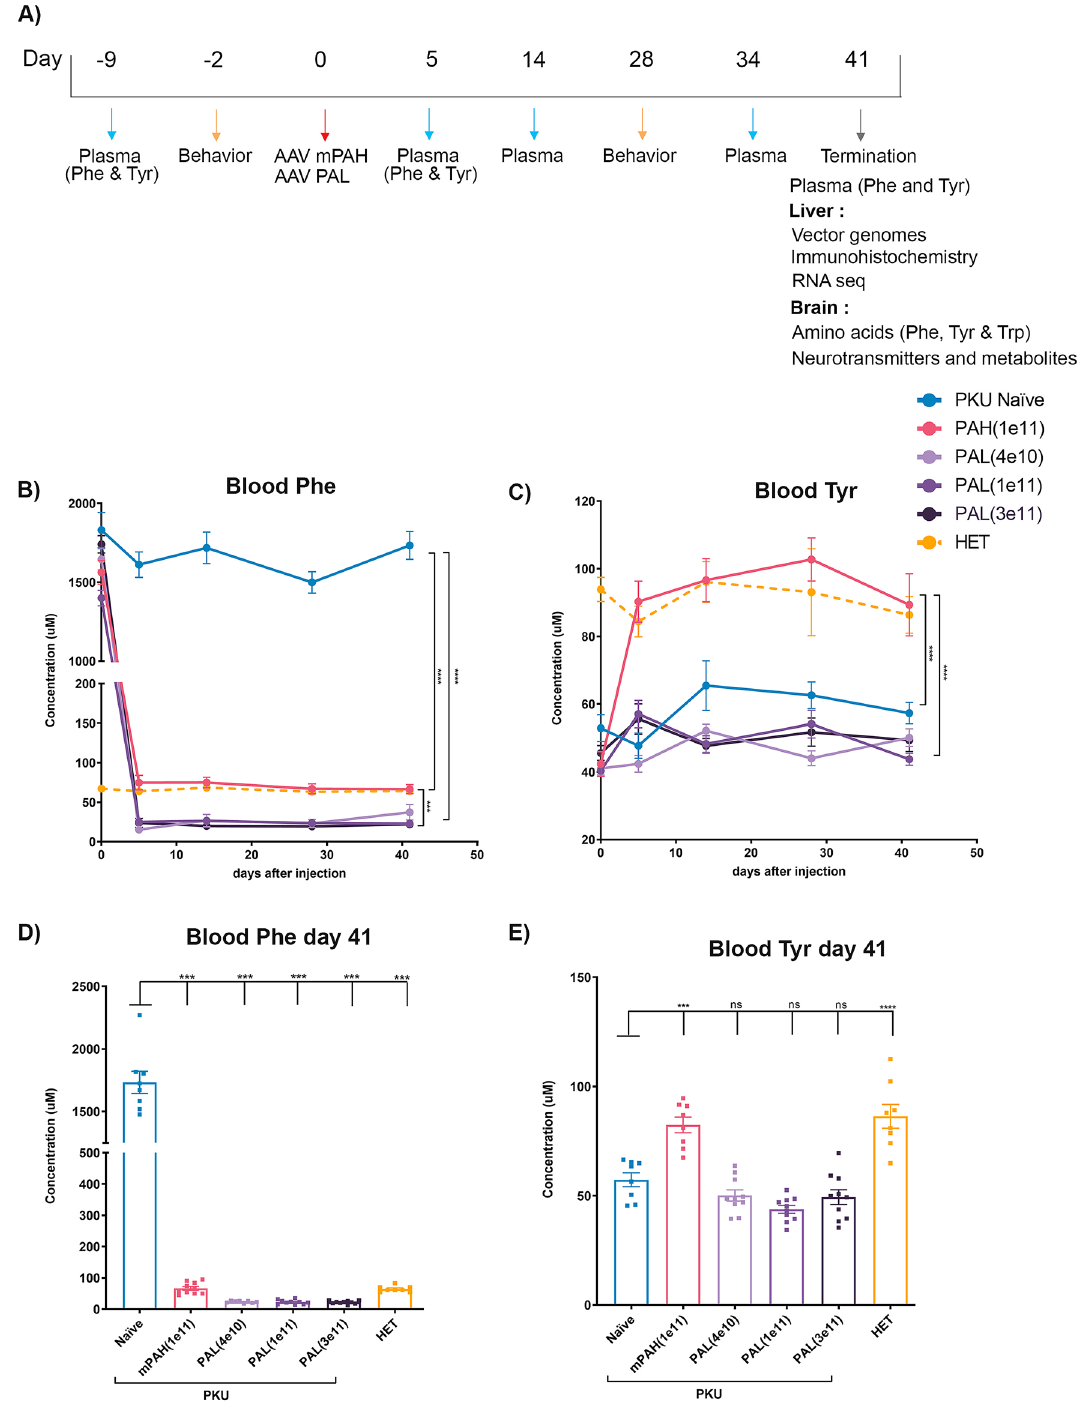
Figure 1. Effect of PAH and PAL gene transfer on blood Phe and Tyr levels after gene delivery to PAH enu2 mice. (A) Schematic of in-vivo study design. PAH and PAH encoding AAV vectors were administered by one-time IV delivery on Day 0. (B) Blood Phe levels were measured in naïve PAH enu2 mice, PAH enu2 mice administered with PAH (1e11 vg) or PAL (4e10, 1e11 or 3e11 vg/mouse) and HET mice at day 9 (baseline) and days 5, 14, 34 and 41 post treatment. Significant reduction in blood Phe levels was observed in both PAH and PAL in PAH enu2 mice as compared to naïve PAH enu2 mice. PAH enu2 PAL treated mice show lower Phe than HET mice while PAH treated mice maintain Phe levels comparable to HET mice. (C) Significant increase in blood Tyr to levels comparable to HET mice were achieved in PAH treated mice but not in PAL treated mice. Two-way ANOVA Mixed effect analysis was performed, ***p < 0.001. (D) Blood Phe continued to remain low in PAH and PAL PAH enu2 mice until the end of the study. (E) Blood Tyr remained normal in PAH PAH enu2 mice till the end of the study. Treatment groups consisted of n = 8–10 animals. Statistics by One-way ANOVA Tukey’s multiple comparison, ***p <